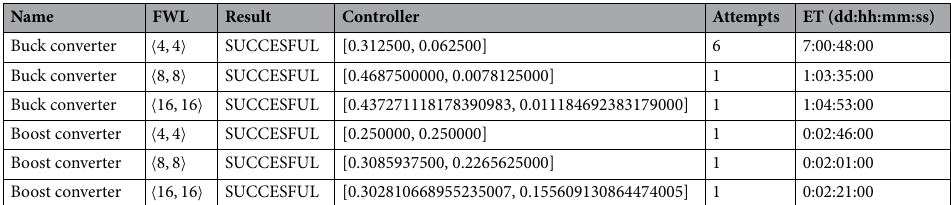
Table 3. Experiments for settling time only. It contains information about the converter name, FWL format, synthesis result, the synthesized controller, number of attempts to synthesize the controller, and total synthesis time.